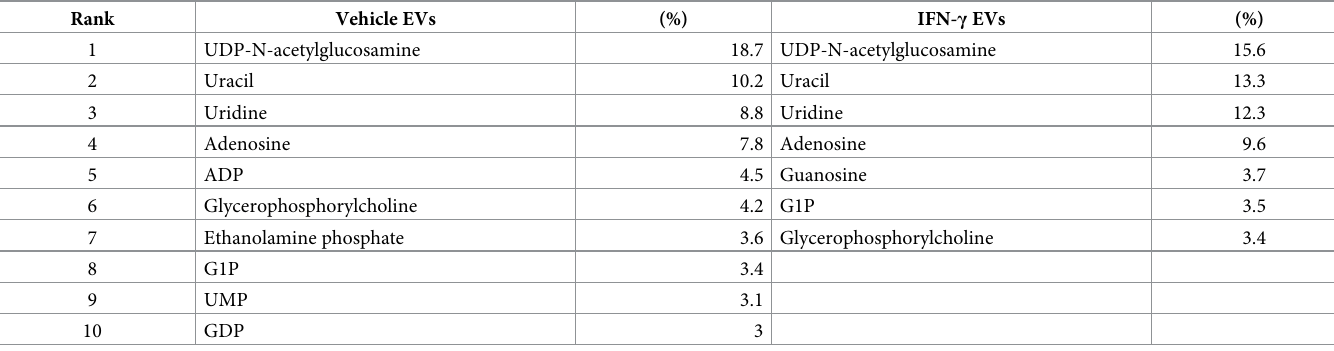
Metabolites in EVs from vehicle-treated D3H2LN cells (vehicle EVs) and EVs from IFN- γ -treated D3H2LN cells (IFN- γ EVs), which account for 3% of total metabolites in each EV, are ranked according to the amount detected. The percentage of each metabolite in both types of EVs cannot be compared directly because the average amount of total metabolites in IFN- γ EVs was 2.4 μ M, whereas that in vehicle EVs was 1.9 μ M. All experiments were performed using three biological replicates. UDP-N-acetylglucosamine, uridine diphosphate N-acetylglucosamine; ADP, adenosine diphosphate; G1P, glucose-1-phosphate; UMP, uridine monophosphate; GDP, guanosine diphosphate.